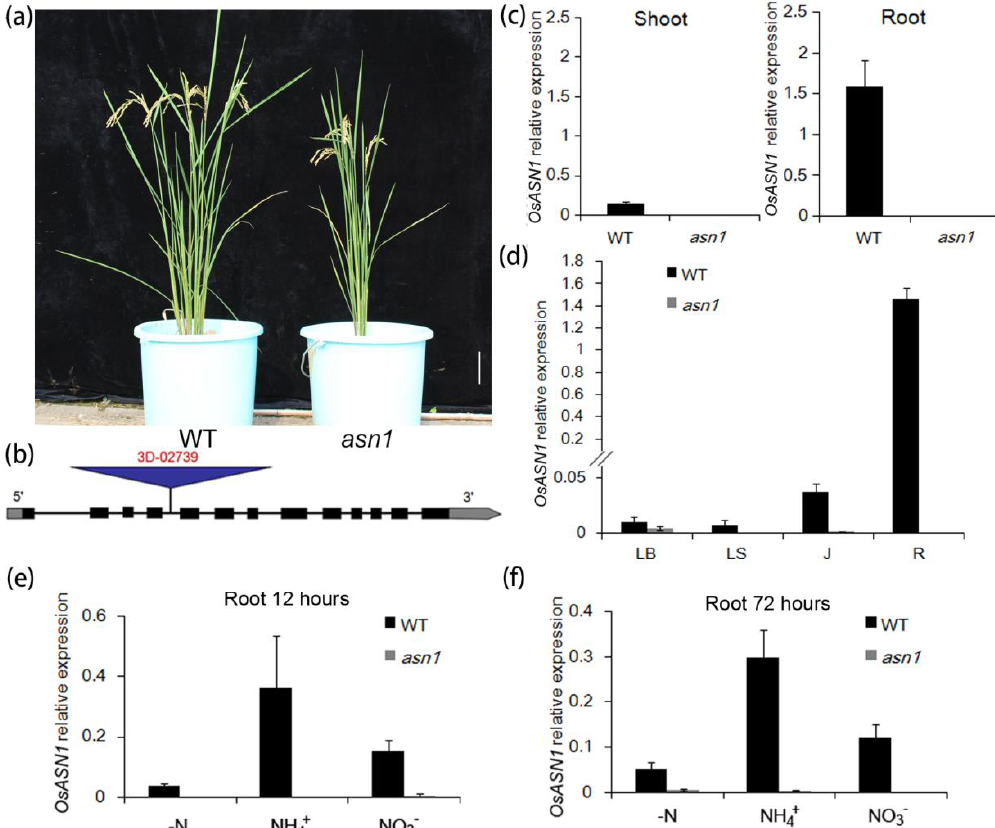
Figure 1. Isolation of a T-DNA insertion mutant. ( a ) Wild type (WT) and T-DNA insertion mutant asn1 ; ( b ) position of T-DNA insertion into OsASN1 genome; ( c ) relative expression of OsASN1 in shoot and root of seven-day-old seedling; ( d ) relative expression of OsASN1 in leaf blade (LB), leaf sheath (LS), junction (J), and root (R) of 21-day-old seedling; ( e ) relative expression of OsASN1 in the root 12 hours after nitrogen deficient ( – N), 2.5 mM NH 4+ , and 2.5 mM NO 3 − treatments; ( f ) relative expression of OsASN1 in root 72 hours after nitrogen deficient treatment, 2.5 mM NH 4+ , and 2.5 mM NO 3 − treatment.The values are the transcriptional expression level of OsASN1 to OsActin (internal standard control) by quantitative Polymerase Chain Reaction (qPCR). The scale baris 10 cm. Data are mean ± S.D. ( n = 3).